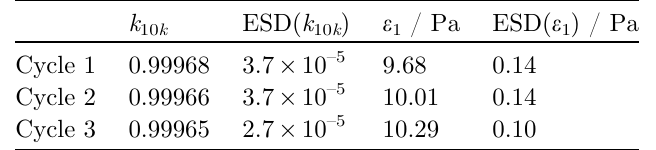
Table 1. Modelling errors of the RSG for three different pressure ranges.